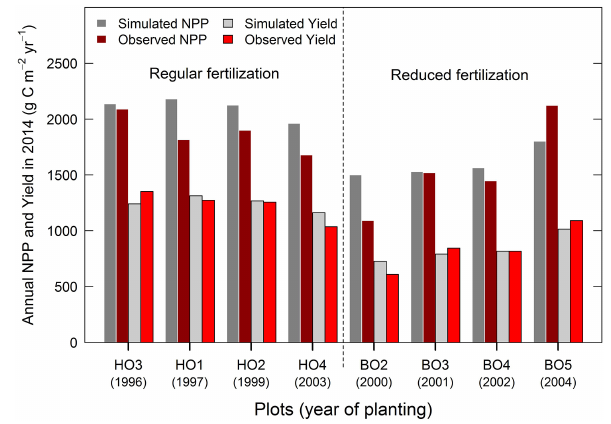
Figure 9. Validation of LAI with eight independent oil palm sites (sequence in plantation age) from the Harapan (regular fertilization) and Bukit Duabelas (reduced fertilization) regions: (a) shows the LAI development of each site simulated by the model since plant- ing; (b) shows the comparison of field measured LAI in 2014 with model.